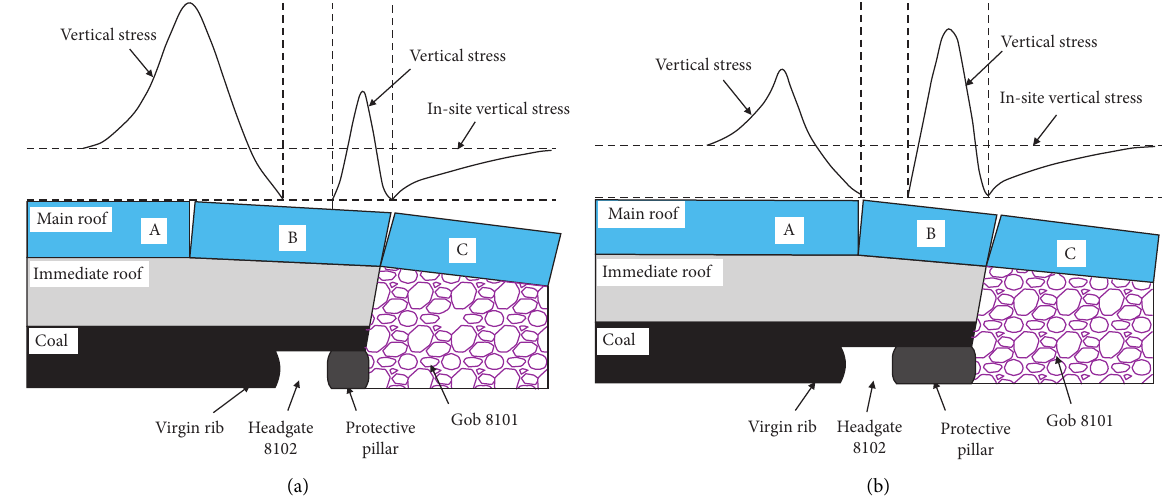
Figure 19: Failure modes of the protective pillar. (a) 5m wide. (b) 20m wide.